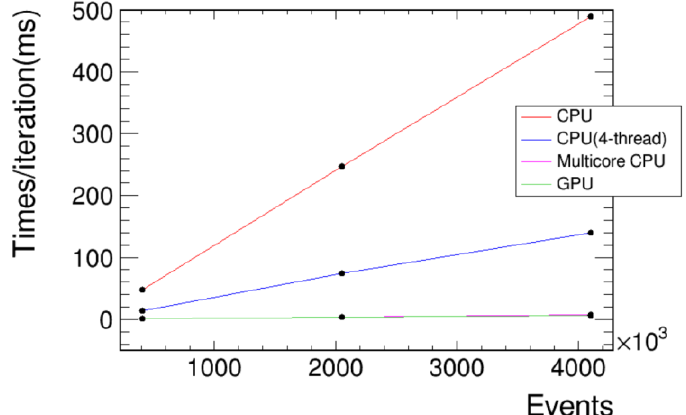
Fig. 4. Performance of